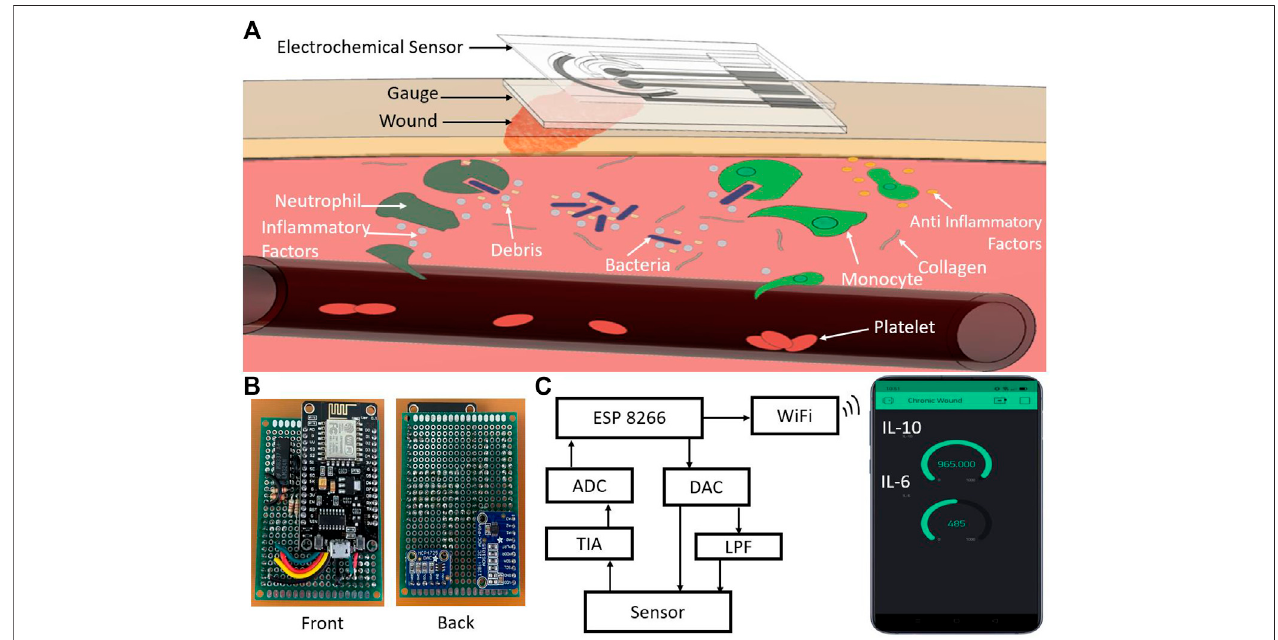
FIGURE1|(A) Schematicillustrationofthe fl exiblesmartwounddressingplacedatthewoundsiteformultiplexedmonitoringofIL-6andIL-10. (B) Opticalimageof the front and back side of the developed IoT-enabled potentiostat. (C) Block diagram of the IoT-enabled chronic wound analysis system. ADC: Analog-to-digital converter, DAC: Digital-to-analog converter, LPF: Low-pass fi lter, and TIA: Transimpedance ampli fi